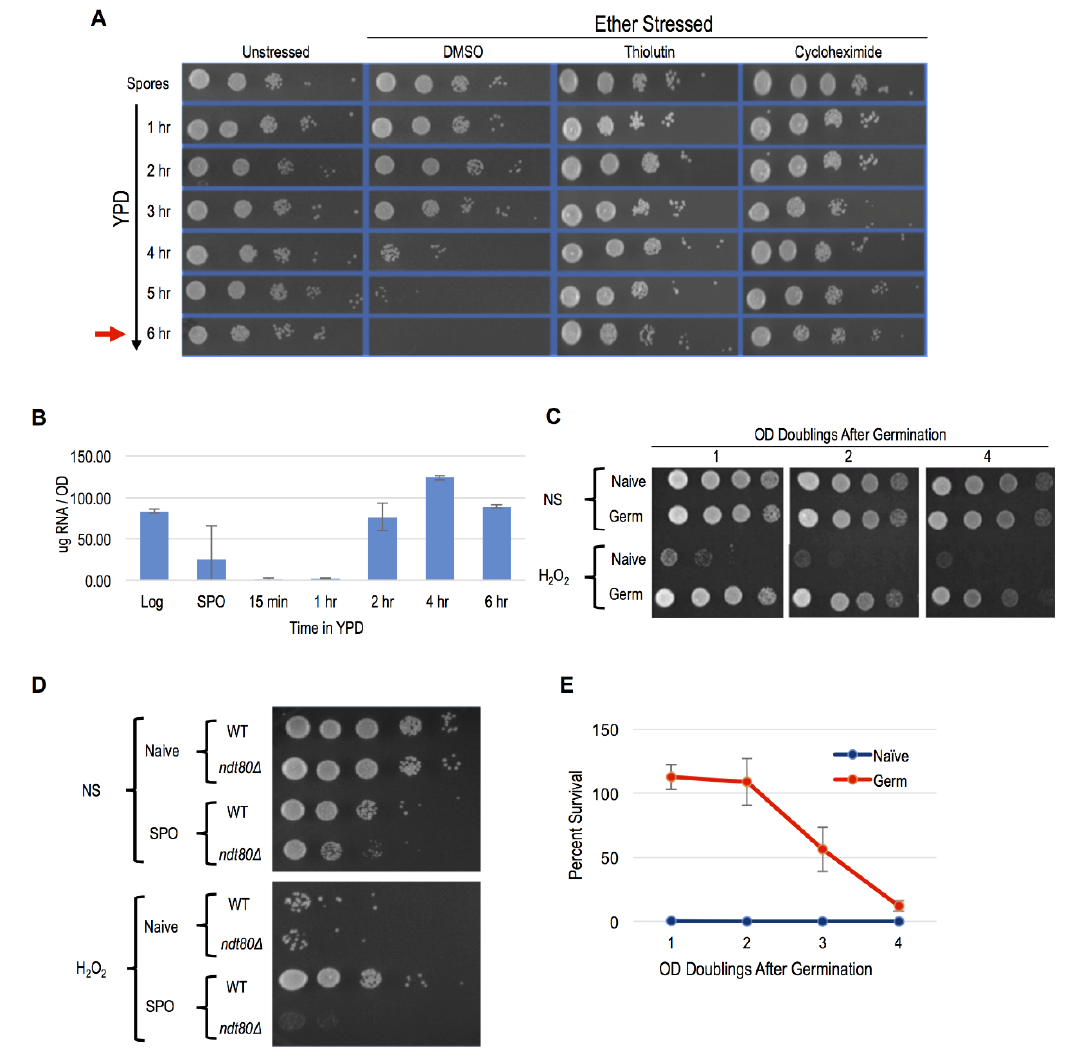
FIGURE 1: Peroxide resistance persisted following germination. (A) Sporulated cells were diluted into YPD media and interrogated with ether treatment. Survival was determined by spotting onto Synthetic complete (SC) plates. The timepoint at which 1 OD doubling was observed is indicated at the 6 hours timepoint and denoted with a red arrow. 10-fold serial dilution of cells is shown. Unstressed - cells germinated without any treatment. DMSO - cells treated with control vector for thiolutin and cycloheximide. Thiolutin -cells treated with 10ug/ml of thiolutin. Cycloheximide - cells treated with 2ug/ml cycloheximide. (B) Extractable RNA levels during germination of cells cultured in YPD are shown. Samples were taken from mid-log cells (Log), spores (SPO), and germinating cells in YPD at 15 min, 1hr, 2hr, 4hr, and 6 hours after release from sporulation. (C) 10-fold serial dilution of H 2 O 2 stress resistance spot assay; Naive represent cells maintained at mid-log and Germ repre- sent cells growing after germination in YPD media. (D) 10-fold serial dilution of H 2 O 2 stress resistance spot assay; WT and ndt80 Δ/∆ cells were grown in YPD (Naive) or sporulation media (SPO) and with (H 2 O 2 ) or without (NS) peroxide treatment. (E) CFU quantification of resistance to 4 mM H 2 O 2 after germination is plotted. Error bars represent 1 standard error of the mean from 3 biological